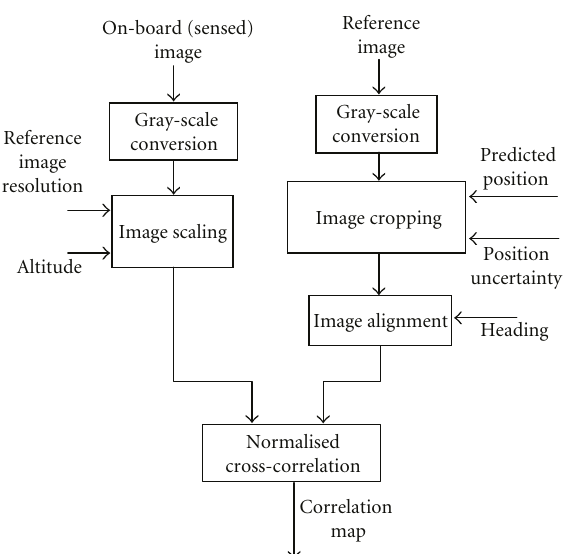
Figure 5: Image registration